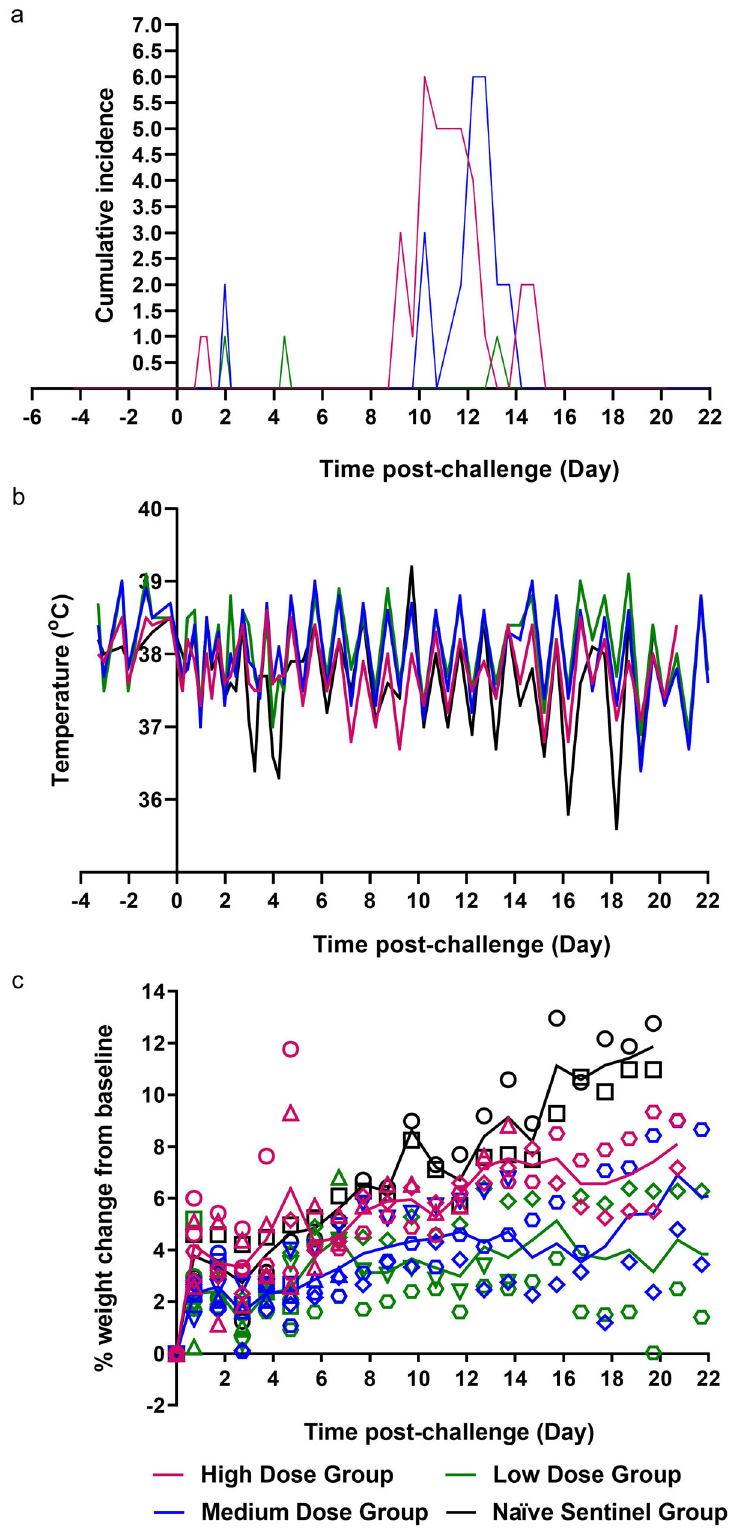
immune response seen in the lung MNCs (Supplementary Fig. 3) of the naïve sentinel ferret showed a high SARS-CoV-2 speci fi c immune response to whole live SARS-CoV-2, paralleling the detection of neutralising antibodies and SARS-CoV-2 spike speci fi c IgG. These results suggest that this ferret could have inadvertently become infected with